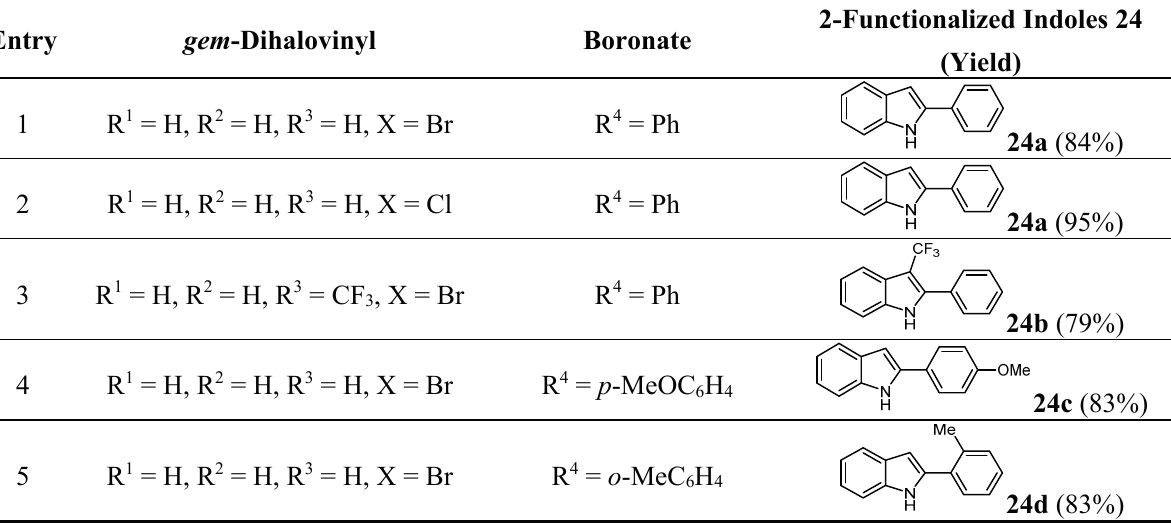
Table 7. Selected 2-functionalized indoles 24 via sequentially Pd-catalyzed Buchwald-Hartwig amination Suzuki-Miyaura-coupling